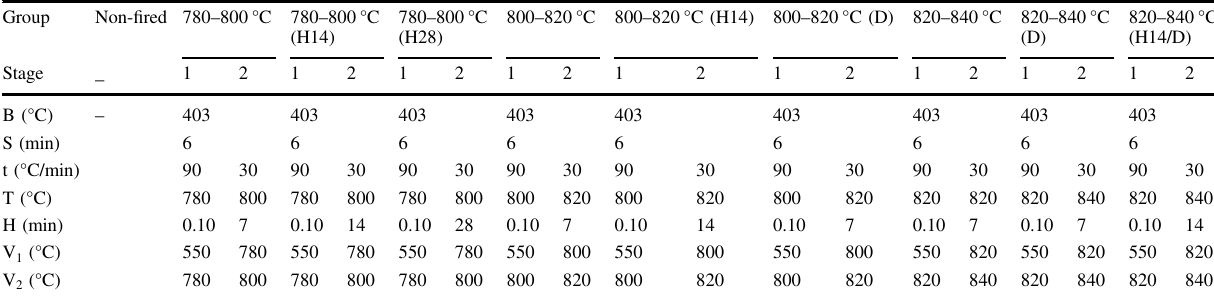
Table 1 Two-stage heating schedules